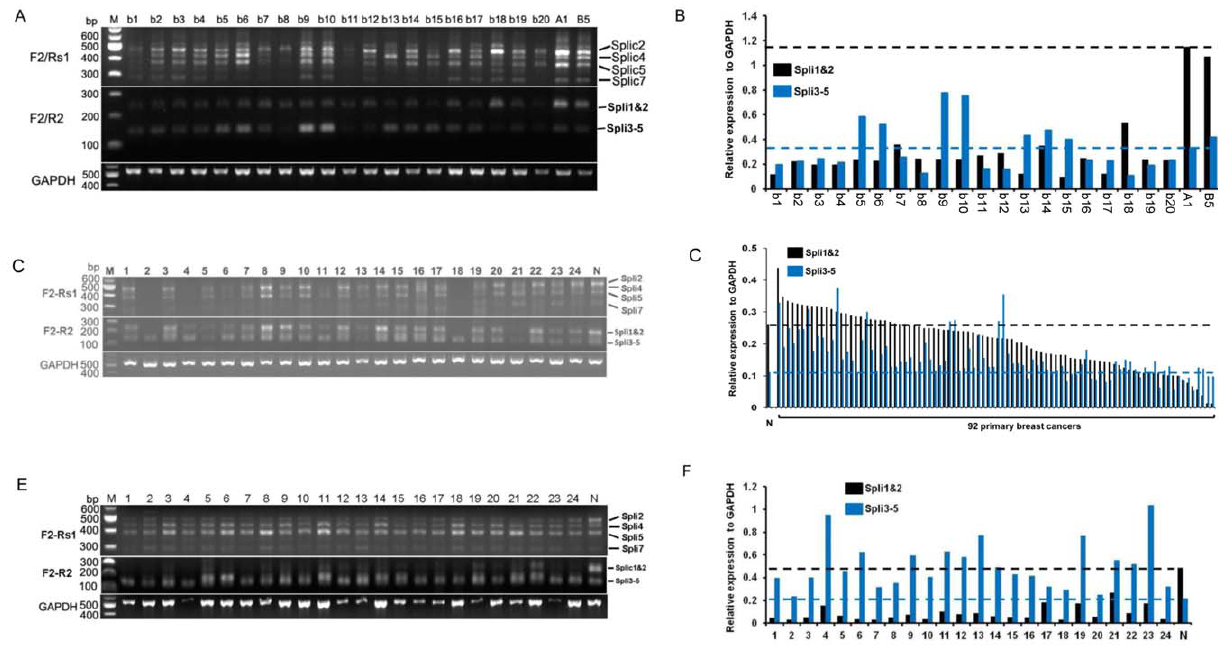
Figure 4. Differential change in mRNA expression level of FBXW7 a AS forms in human cancer. (A) mRNA expression profile of FBXW7 a AS forms in human breast cancer and HMEC cell lines was determined by semi-quantitative RT-PCR using different sets of primers. ‘‘b1 to b20’’ represents 20 different breast cancer cell lines, ‘‘A1’’ stands for 184A1, ‘‘B5’’ for 184B5. (B) The levels of Spli1&2 and Spli3-5 expression were quantified from the experiment shown in (A) lower panel. (C) The representative mRNA expression profile of FBXW7 a AS forms from 92 human primary breast cancers by semi-quantitative RT-PCR using different sets of primers. (D) Quantification of Spli1&2 and Spli3-5 expression levels in 92 human primary breast cancers. (E) The mRNA expression profile of FBXW7 a AS forms in 24 human primary kidney cancers by semi-quantitative RT-PCR using different sets of primers. (F) Quantification of Spli1&2 and Spli3-5 expression levels in 24 human primary kidney cancers. ‘‘N’’ for pooled RNAs from normal tissues, ‘‘M’’ for DNAs ladder